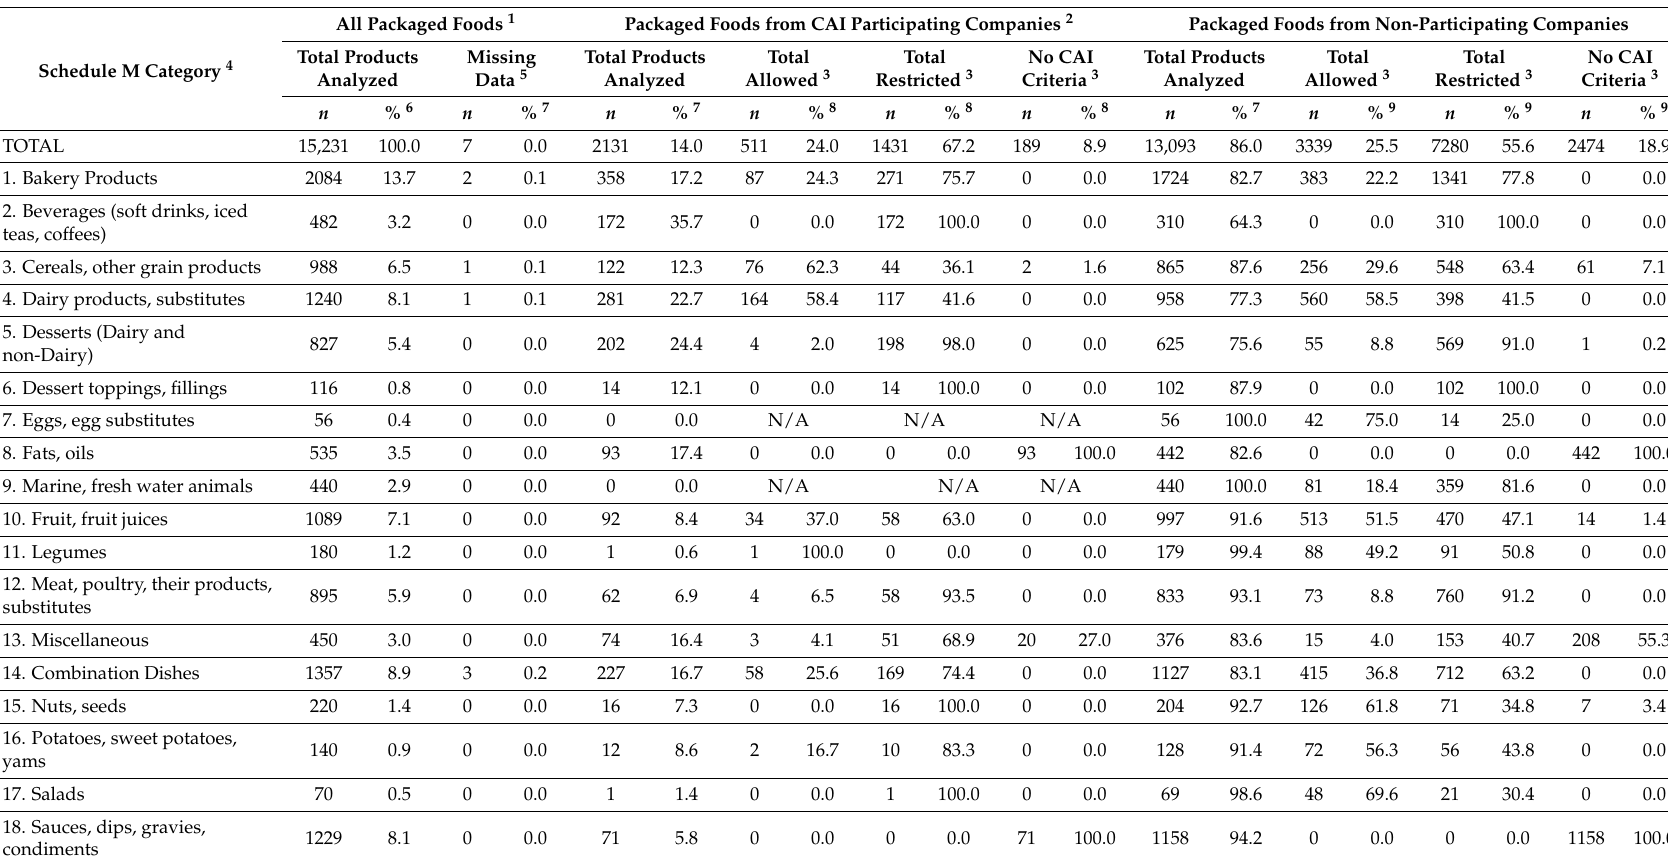
Table 3. Proportion of packaged food and beverage products 1 offered by CAI participating and non-participating companies 2 that would be allowed to be advertised to children according to the CAI’s Uniform Nutrition Criteria 3 , presented overall and by food category 4